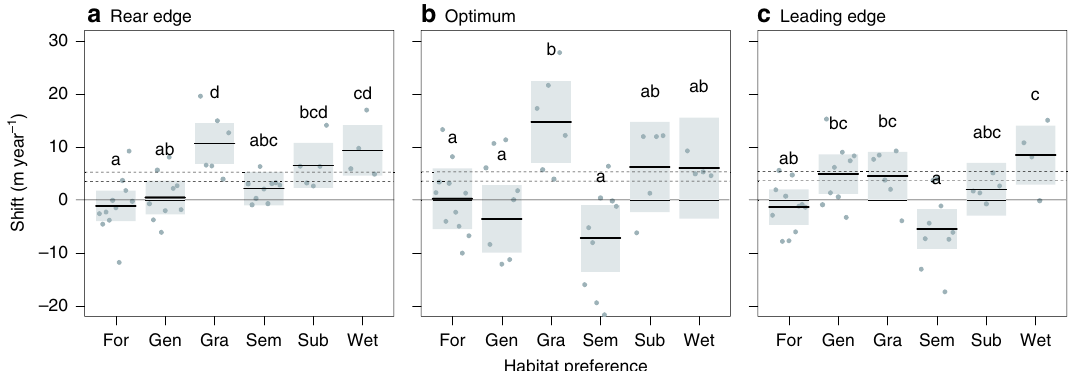
Fig. 6 Elevation range shifts of orchids according to habitat preference. The effect of habitat preference on range shift for a rear edge, b optimum and c leading edge. Solid lines indicate model estimates, while shaded grey areas indicate intervals of con fi dence (95%). Horizontal dashed lines show the expected shift to track climate change based on the current rate of warming in the study area (3.8 – 5.5 m year − 1 ) 2 . Forest: 11 species; generalist: 9 species; grassland: 6 species; semi-natural grassland: 9 species; subalpine: 5 species; and wetland: 4 species. Superscript letters denote signi fi cant differences ( p < 0.05) in shift rates according to linear regression followed by Tukey ’ s post hoc test (see ‘ Methods ’ ). Plots were drawn using the visreg() function with default settings in the visreg package in